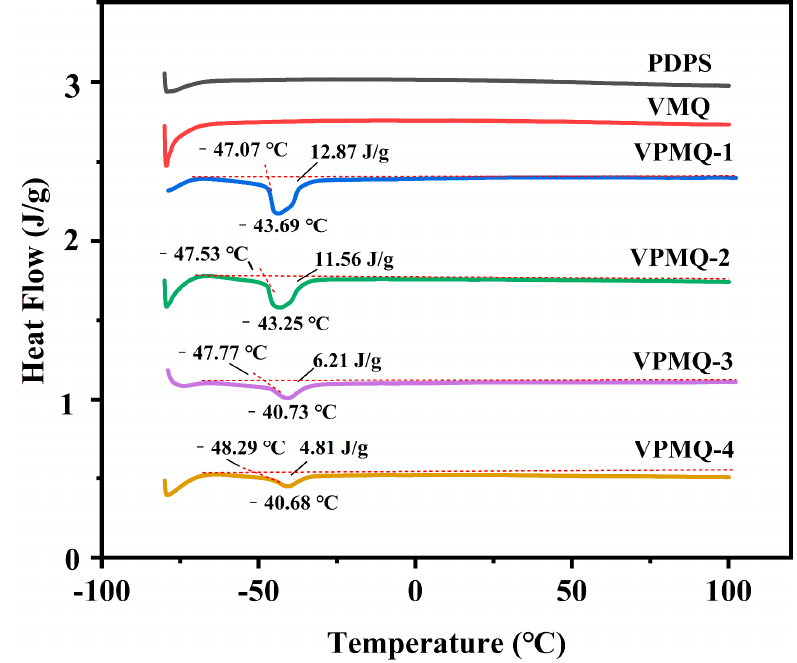
Figure 5. DSC thermograms of PDPS, VMQ and VPMQ samples with a heat rate of 10 °C/min in an N 2 atmosphere.